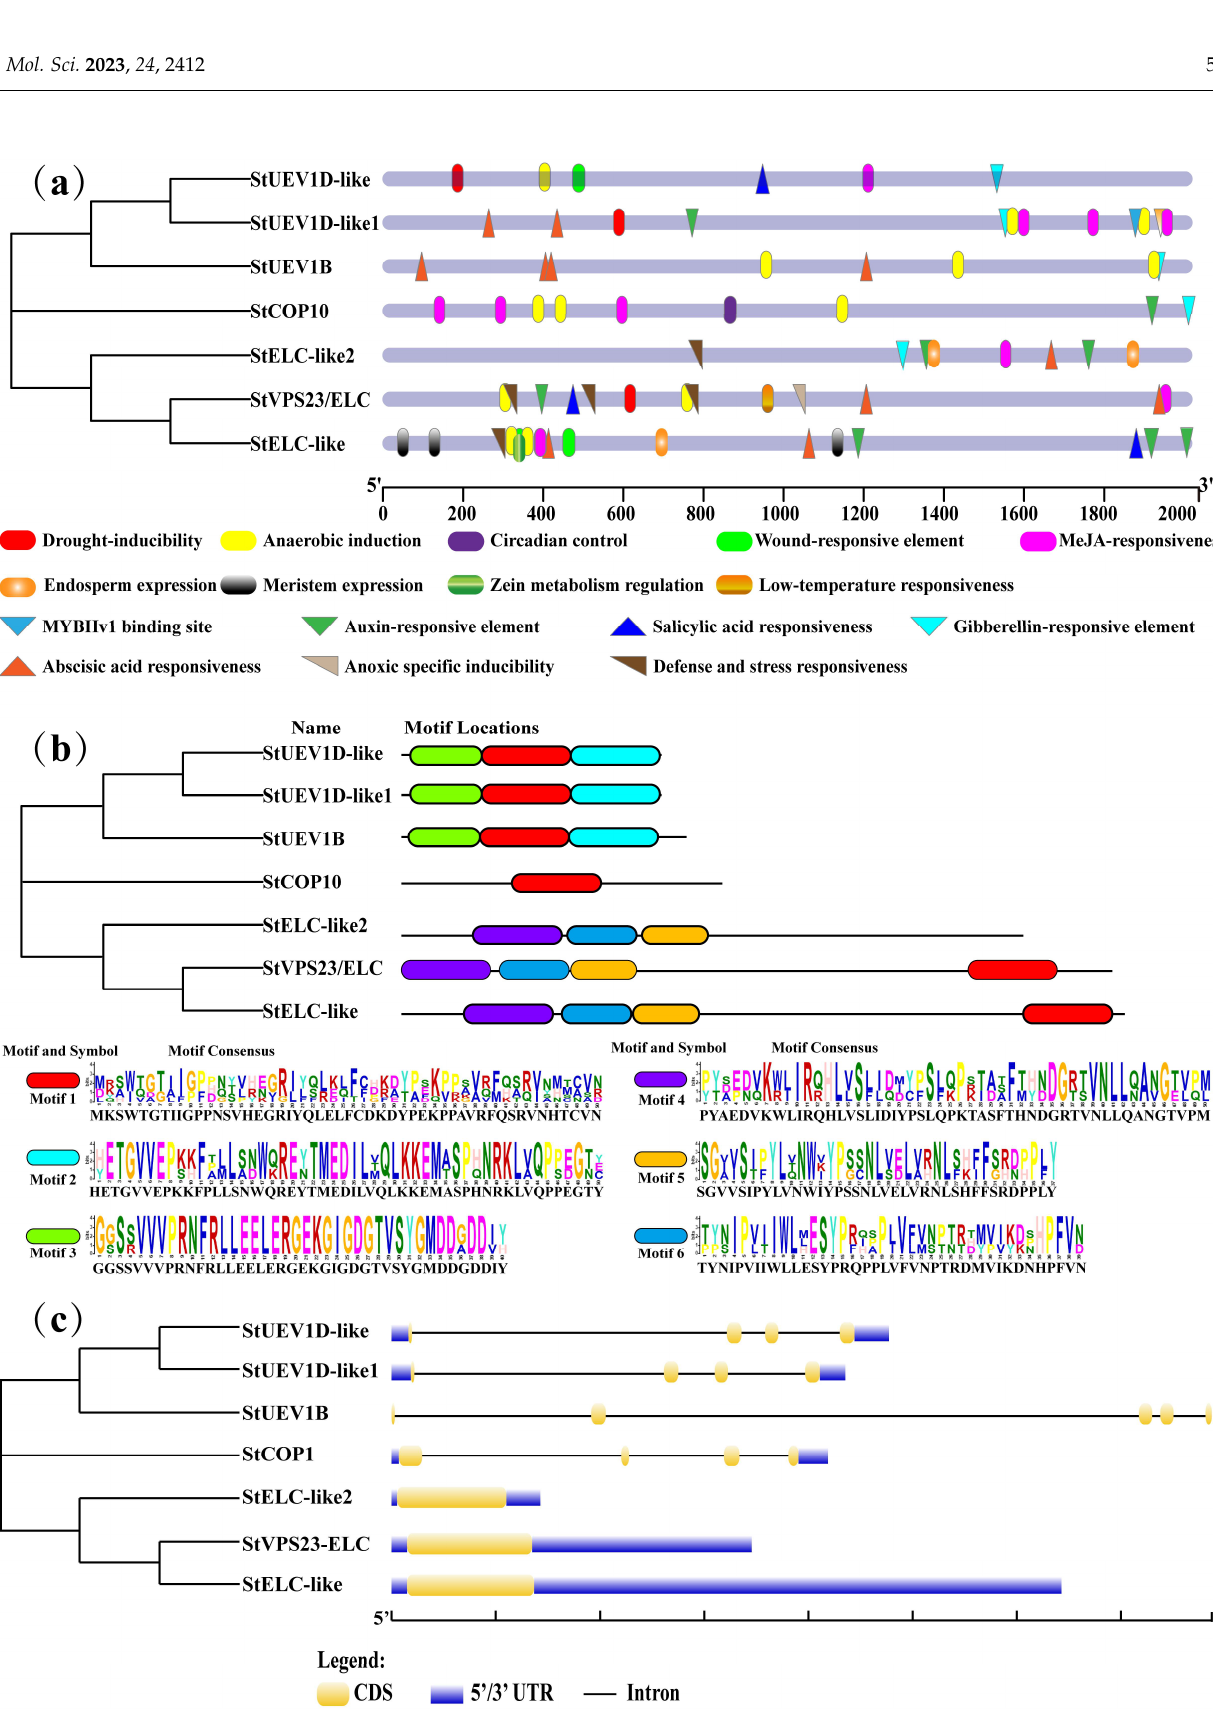
Figure 2. The cis -acting element, conserved motif, and gene structure analysis of UEVs. ( a ) The cis -acting element analysis of StUEVs genes in the promoter region. ( b ) The motif composition analysis of StUEVs . ( c ) The gene structure analysis of StUEVs